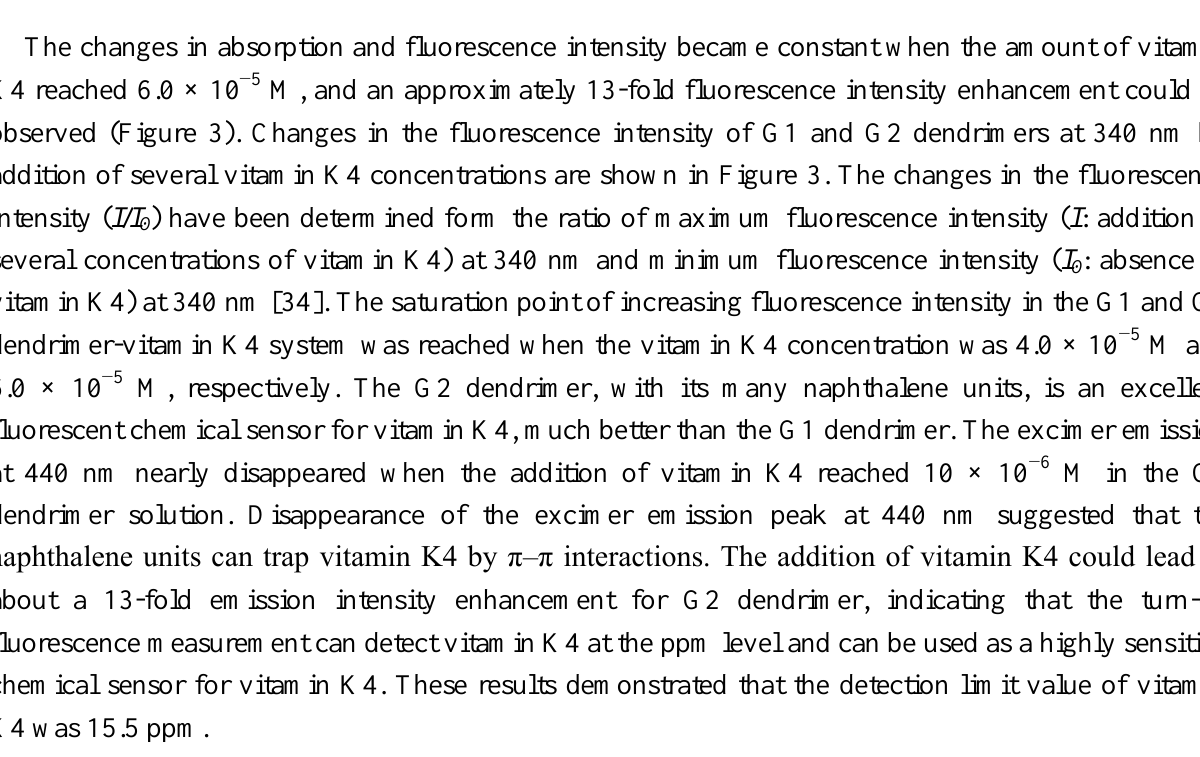
Figure 3. Changes in the fluorescence intensity of G1 (●) and G2 (■) dendrimer as a function of vitamin K4